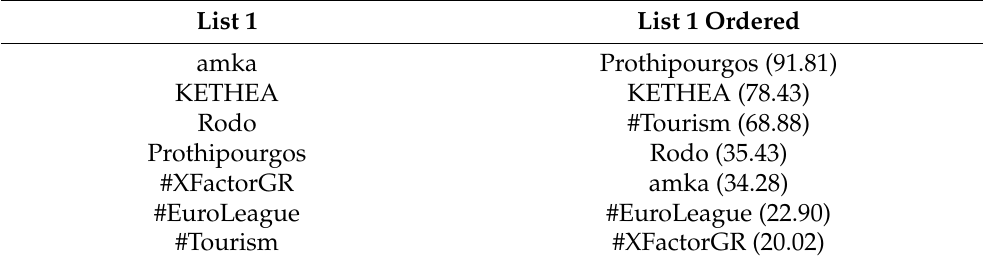
Table 3. Trending topics list received on October